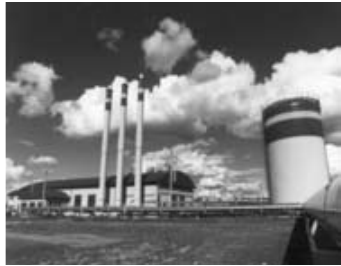
Fig. 7. Geothermal Power